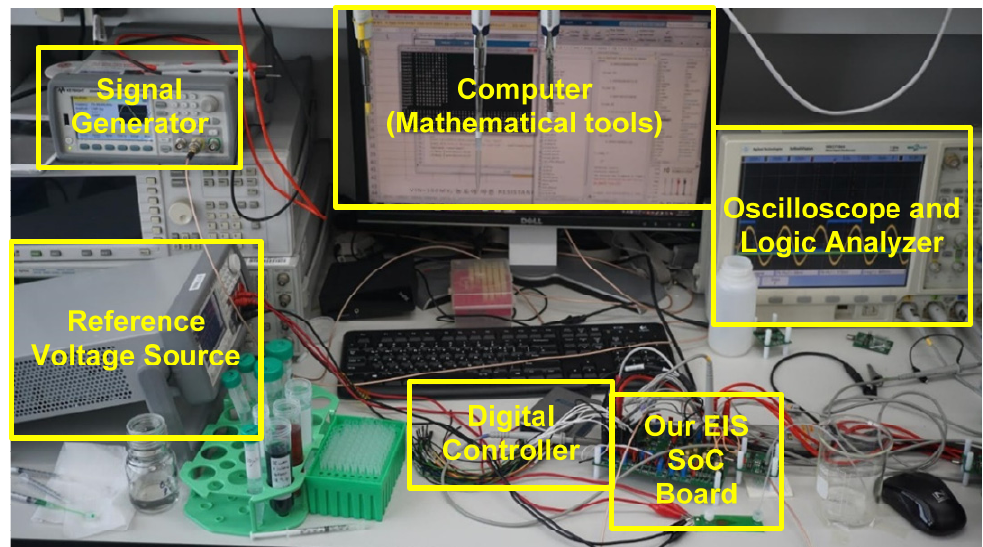
Figure 8. Power breakdown of our EIS SoC at 50 MHz.